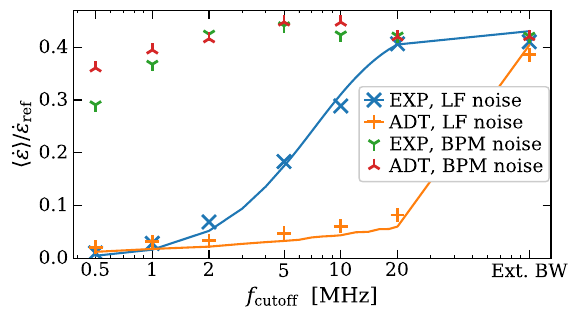
FIG. 3. Average emittance growth for 128 neighboring bunches, affected by either LF noise or BPM noise, using the EXP filter and the ADT filter. The solid lines are the expected emittance growth rates due to LF noise, calculated with Eqs. (11) and (17).